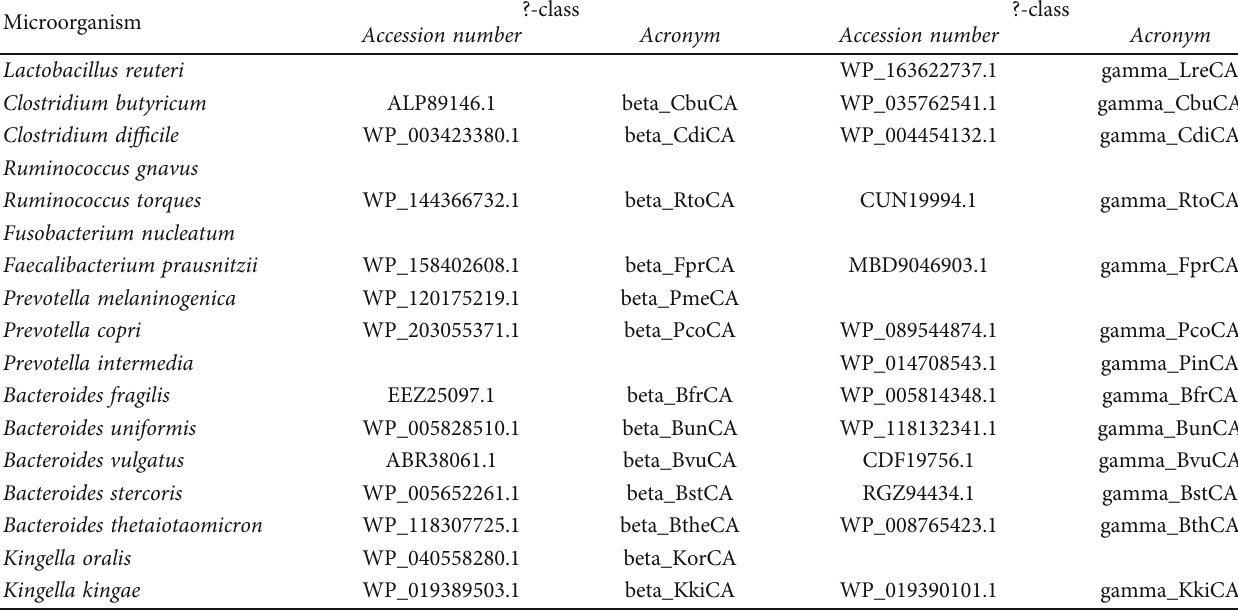
Table 2: Microorganisms, CA accession numbers, and protein acronyms of the amino acid sequences used in the phylogenetic analysis.